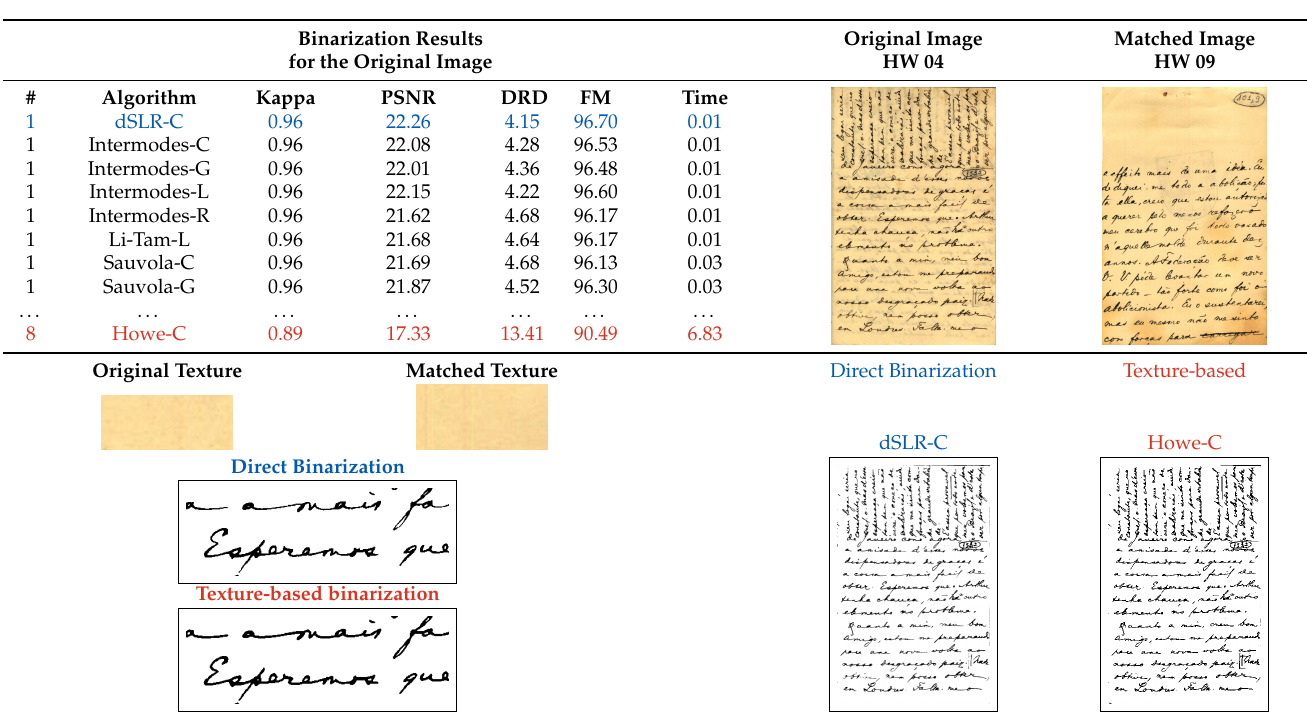
Table 7. Results for image matching with image HW